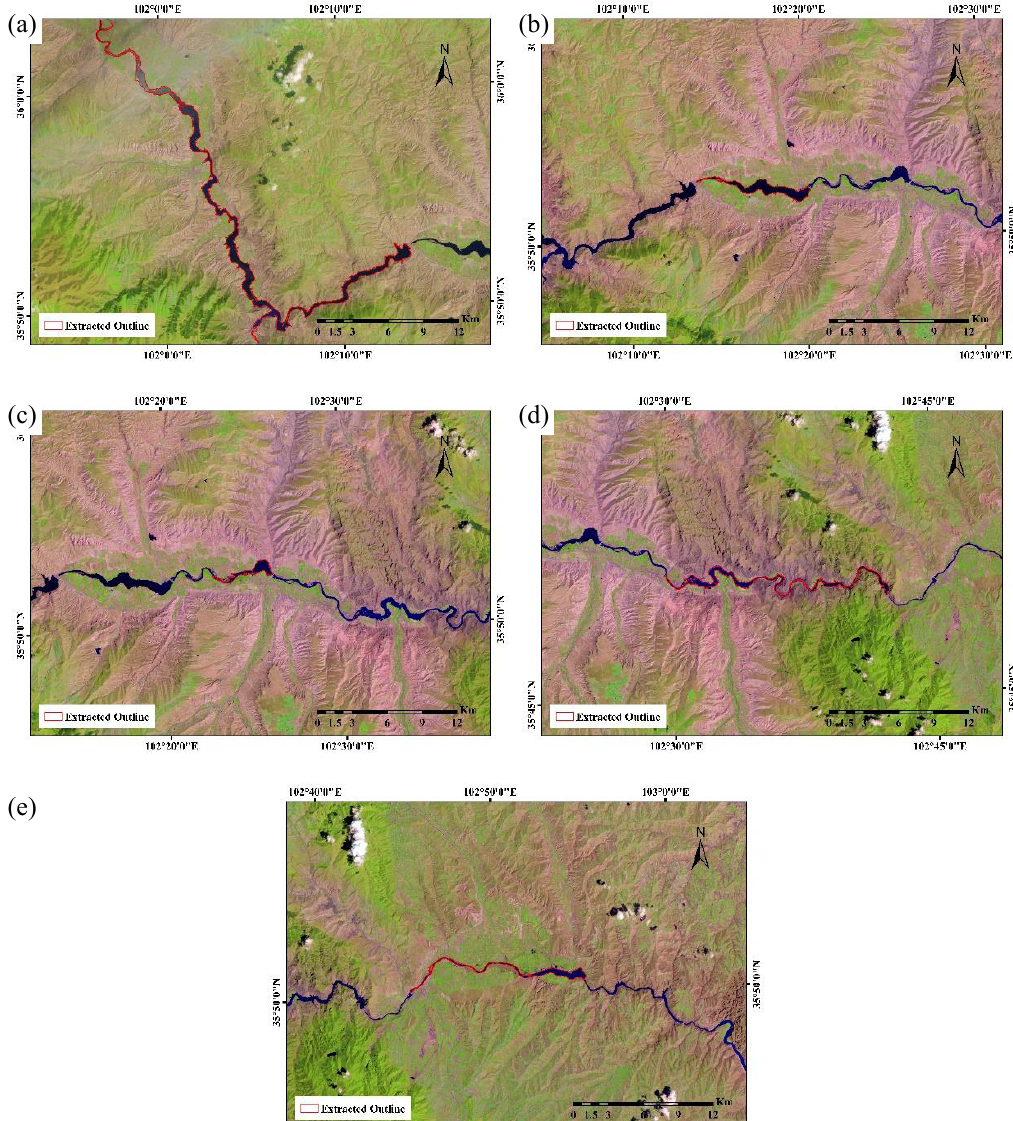
Figure 7. Outlines of the Landsat-derived water surface of Gongboxia Reservoir ( a ), Suzhi Reservoir ( b ), Huangfeng Reservoir ( c ), Jishixia Reservoir ( d ), and Sigouxia Reservoir ( e ).